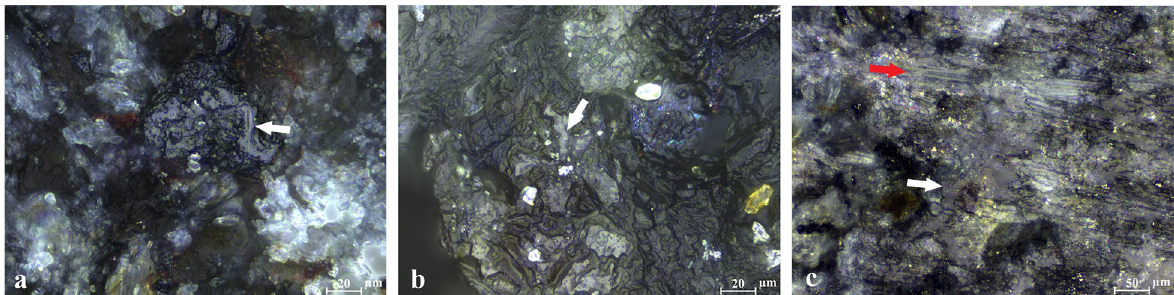
Fig 6. Micropolish produced in the lubricant experiment. (a) Traces from sand and water, showing a patch of bright polish in reticulation marked by an arrow (500x); (b) Sand and oil traces, showing a patch of moderately reflective polish marked by an arrow (500x); (c) Limestone and water traces, showing a combination of bright, rounded, and reticular polish formed from contact with the lubricant, marked by a white arrow, and flat striated opaque polish caused by contact with the hard limestone, marked by a red arrow (200x) (see Table 4).